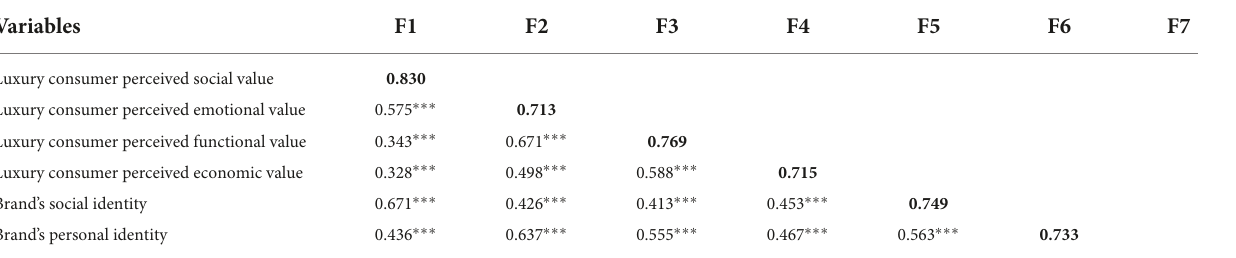
TABLE 4 Assessment of discriminant